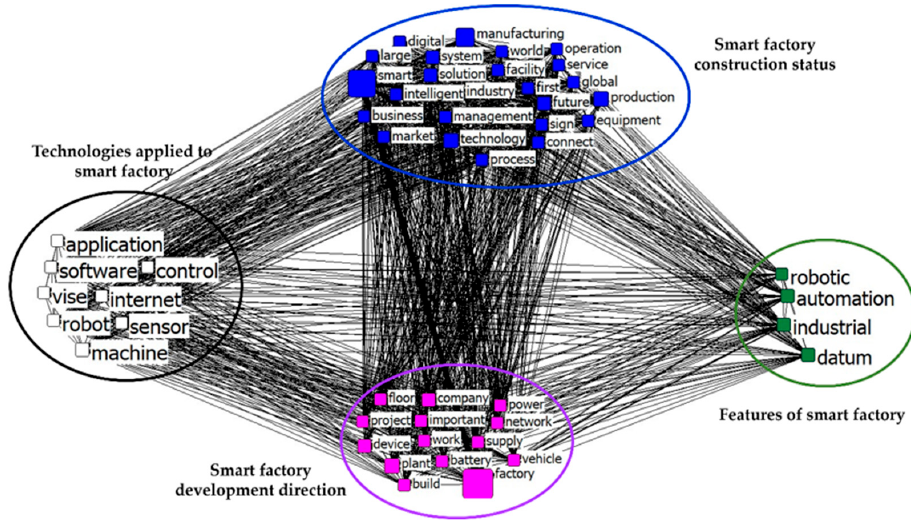
Figure 2. CONCOR analysis of second generation of smart factory.